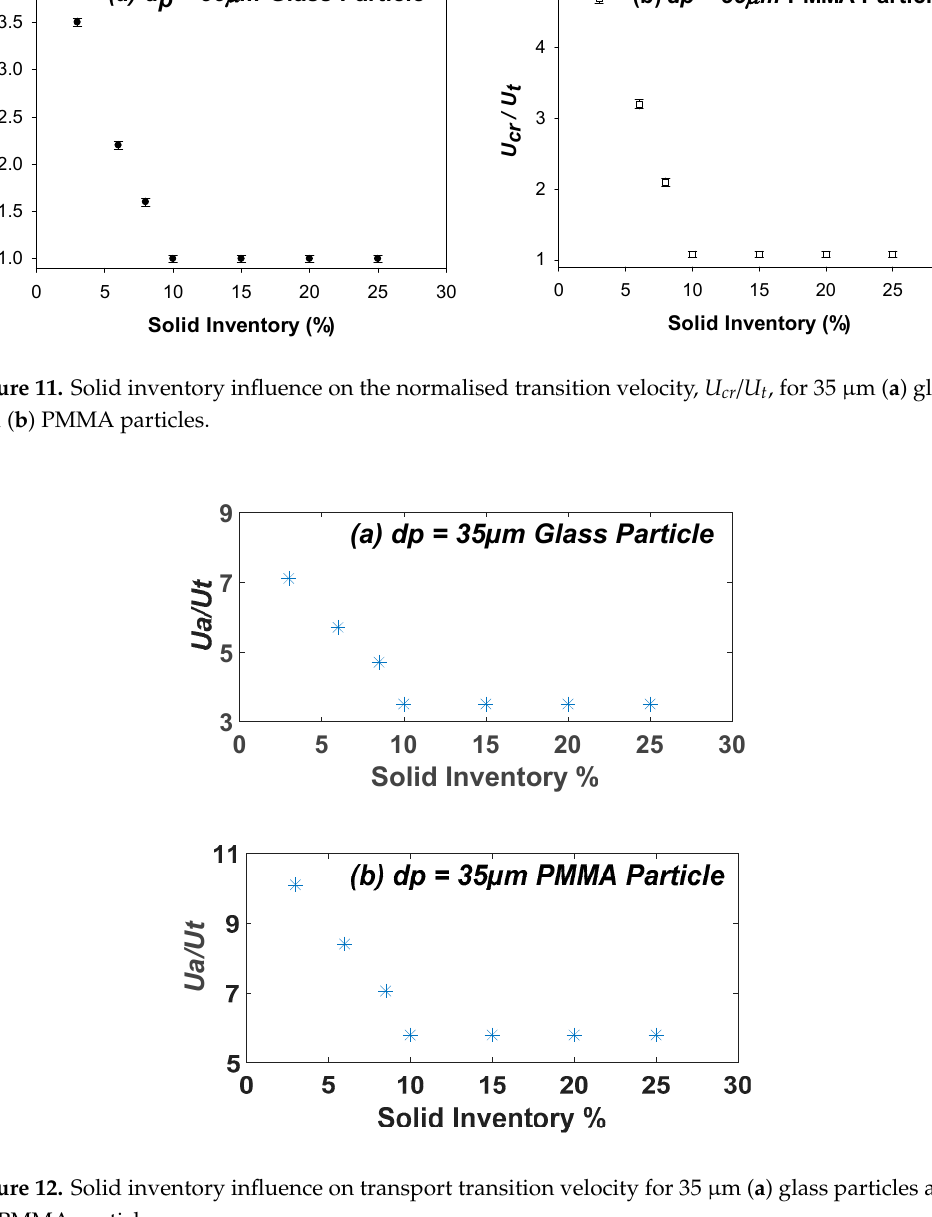
Figure 11. Solid inventory influence on the normalised transition velocity, U cr / U t , for 35 µm ( a ) glass and ( b ) PMMA particles.